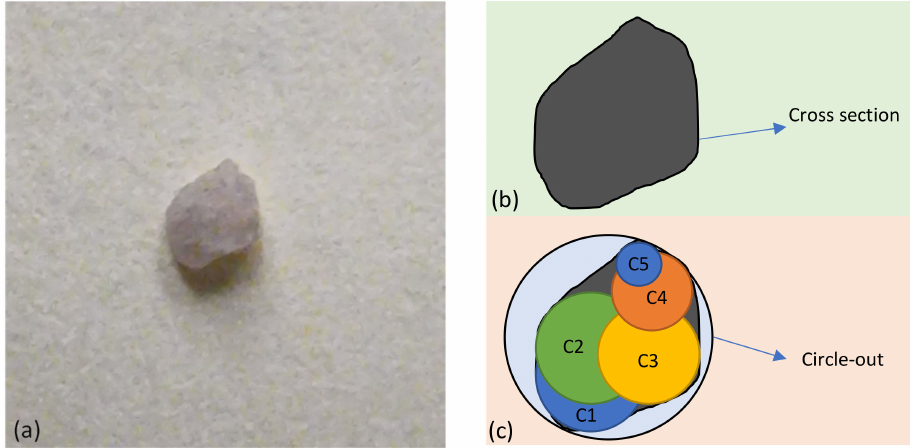
Figure 12. ( a ) Three-dimensional image, ( b ) two-dimensional cross-sectional area and ( c ) calculation of the three shape parameters S , R and ρ for one particle after four cyclic